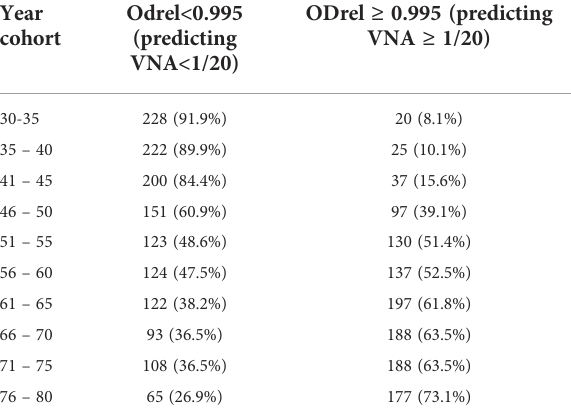
TABLE 5 Predicted VNA by age according to ODrel, n = 2610.